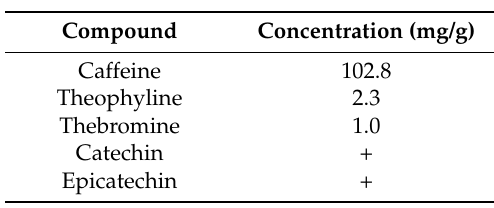
Table 1. Determination of guarana extract (GE) chemical content. The high concentration of caffeine is a hallmark of this species.